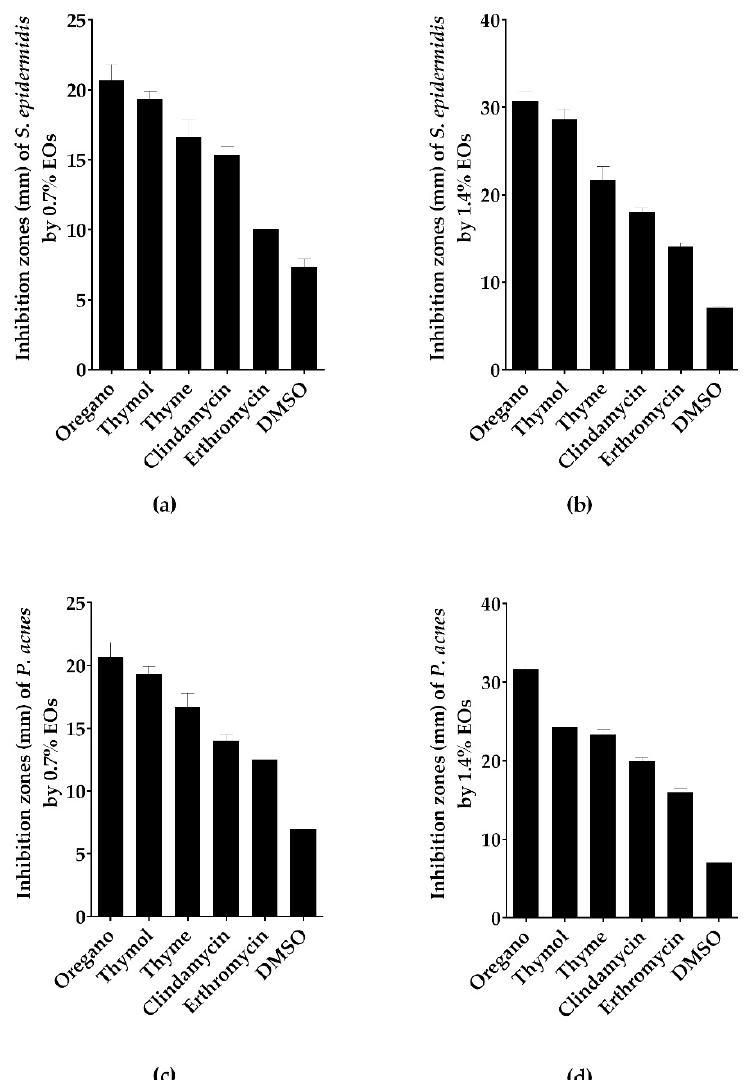
Figure 3. Thymol exhibited lower inhibition zone than oregano EO. Antibacterial activity of thymol and the most bioactive EOs using disc diffusion method (zone of inhibition in mm) against ( a ) S. epidermidis with thymol and EOs at concentration of 0.7%; ( b ) S. epidermidis with thymol and EOs at concentration of 1.4%; ( c ) P. acnes with thymol and EOs at concentration of 0.7%; ( d ) P. acnes with thymol and EOs at concentration of 1.4%. Data is represented as means of inhibition zones (mm) ± SD. Controls used were clindamycin and erythromycin as positive control with DMSO as negative control.